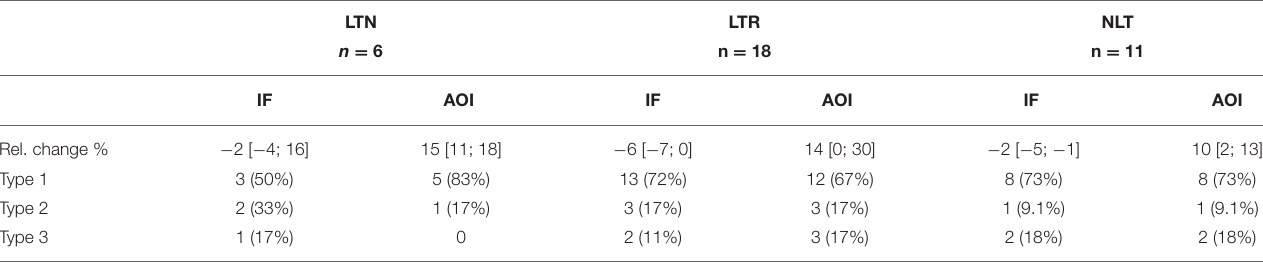
TABLE 2 | Relative changes in IF and AOI post-PVI, according to ablation outcomes, expressed as median with [25th; 75th] percentiles. LTN LTR NLT n = 6 n = 18 IF AOI IF AOI IF AOI Rel. change %